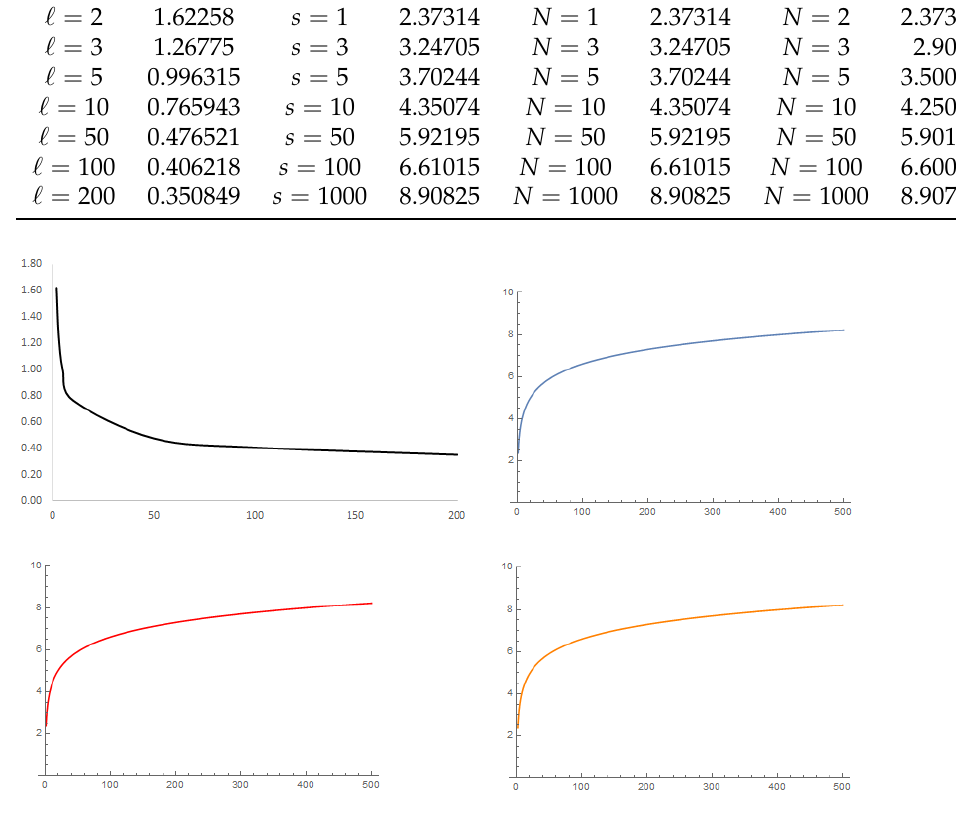
Figure 1. Graphs of h ( T (cid:96) ) (black), h ( T θ ) (blue), h ( T N ) (red), and h ( R N )